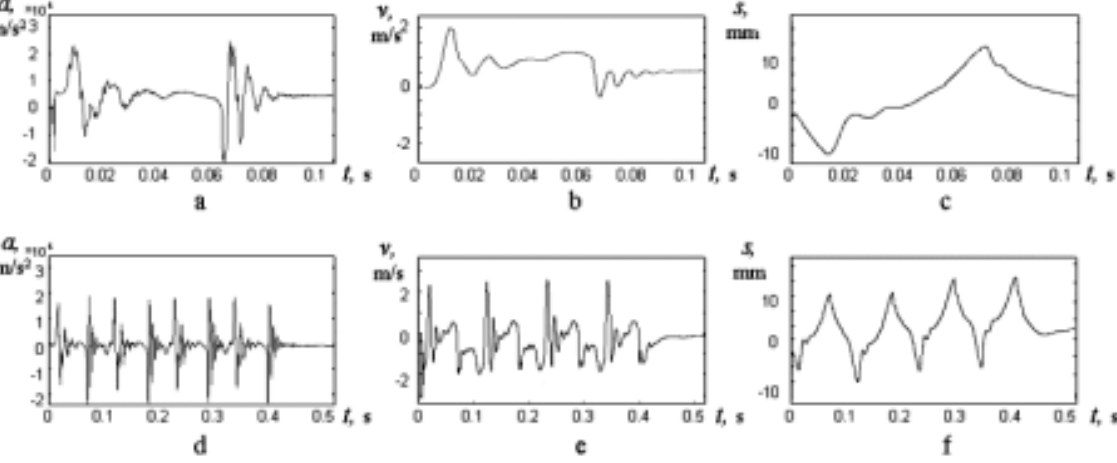
Fig. 7. Experimental characteristics of dynamic parameters of the butt-stock movement of AK-47S training gun: acceleration (a), velocity (b), displacement (c) in single shot mode, And acceleration (d), velocity (e), displacement (f) in serial shot